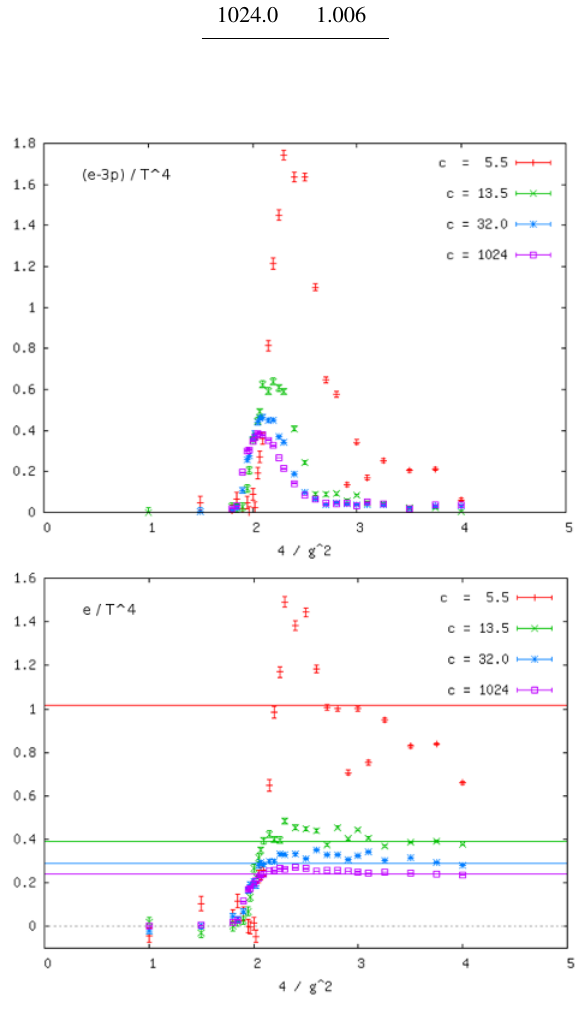
Fig. 7. The interaction measure and the energy density divided by T 4 vs. coupling for the Tsallis parameters c = 5 . 5 , 13 . 5 , 32 . 0 , and 1024 .